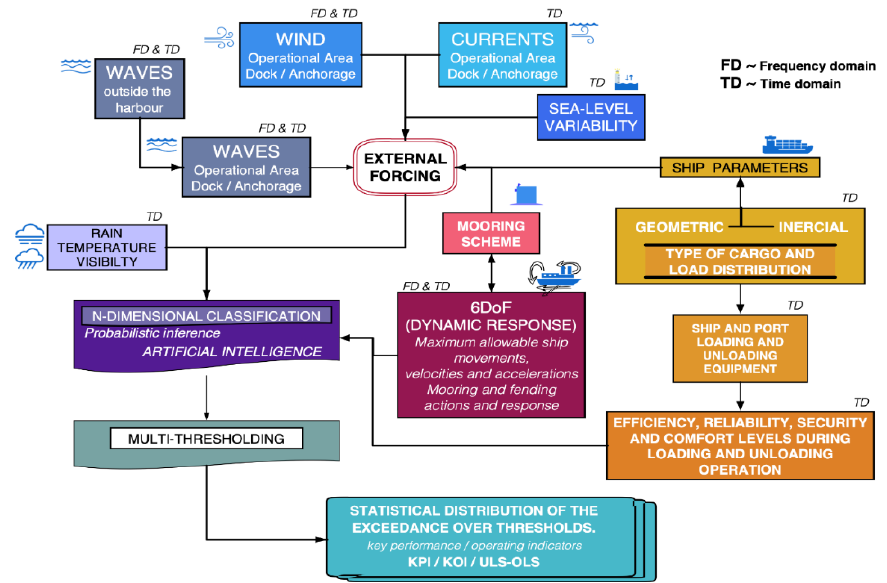
Figure 9. Scheme of an inference model based on an n-dimensional classification of forcing agents and the ship response. Own elaboration.